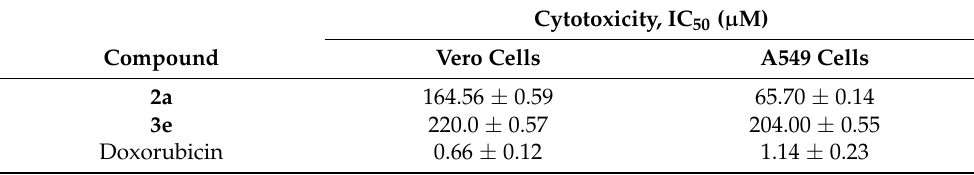
Table 5. The cytotoxicity of compounds 2a and 3e on Vero and A549 cell Table 4. Pharmacokinetics properties predictions of compounds 2a , 3e and 3g .